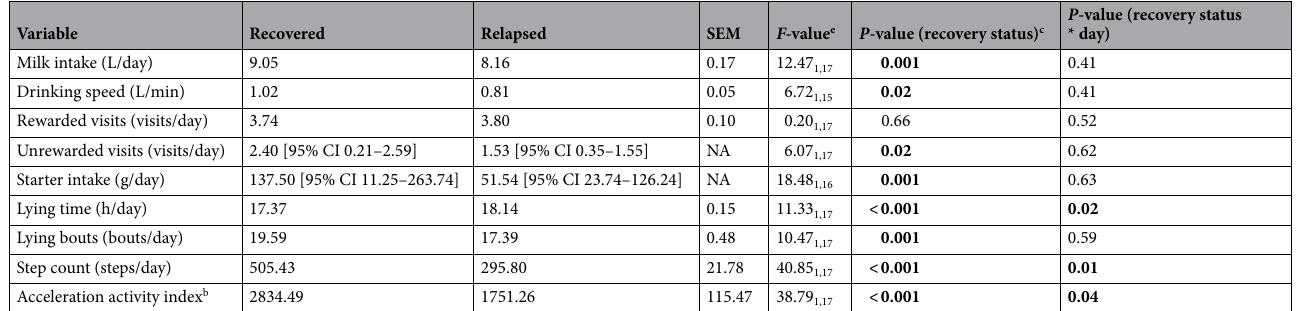
Table 1. Association of recovery status (recovered or relapsed) with feeding and activity behaviors of dairy calves (n = 19 matched pairs a ) in the 10 days after initial Bovine Respiratory Disease diagnosis and antimicrobial therapy on d 0. Feeding behaviors (average drinking speed, milk intake, and number of rewarded visits) were recorded by an automated milk feeder from calves offered 10 L of milk replacer/day, and activity measures (lying time, step count, acceleration activity index b and lying bouts) were recorded by a pedometer. Results are reported as least squares means c , or geometric means d for unrewarded visits and starter intake. a All calves were pair matched to healthy calves by age at diagnosis, birthdate, and gender. Bovine Respiratory Disease was defined as a clinical score of at least 5 26 and lobar lung consolidation 27 . b The acceleration activity index was generated by the commercial software algorithm (IceRobotics, Scotland) based on a calf’s daily average acceleration rate and step count. c Significance are in bold P < 0.05. d Non-normally distributed variables were transformed with log 10 for significance P < 0.05. e Superscripts refer to numerator and denominator degrees of